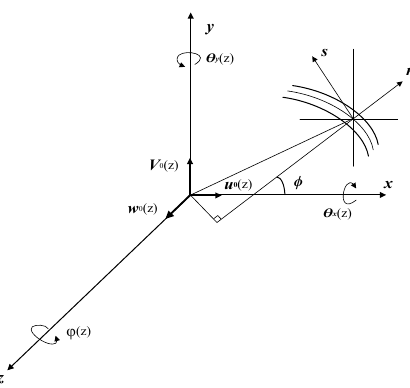
Figure 14. Internal force and displacement components of composite sandwich laminated box beam.